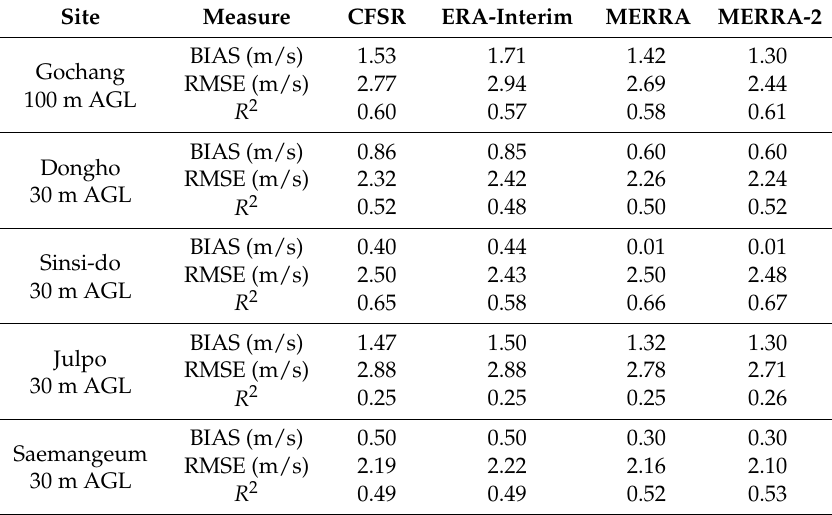
Table 6. Comparison between onshore measurements and reanalysis data.